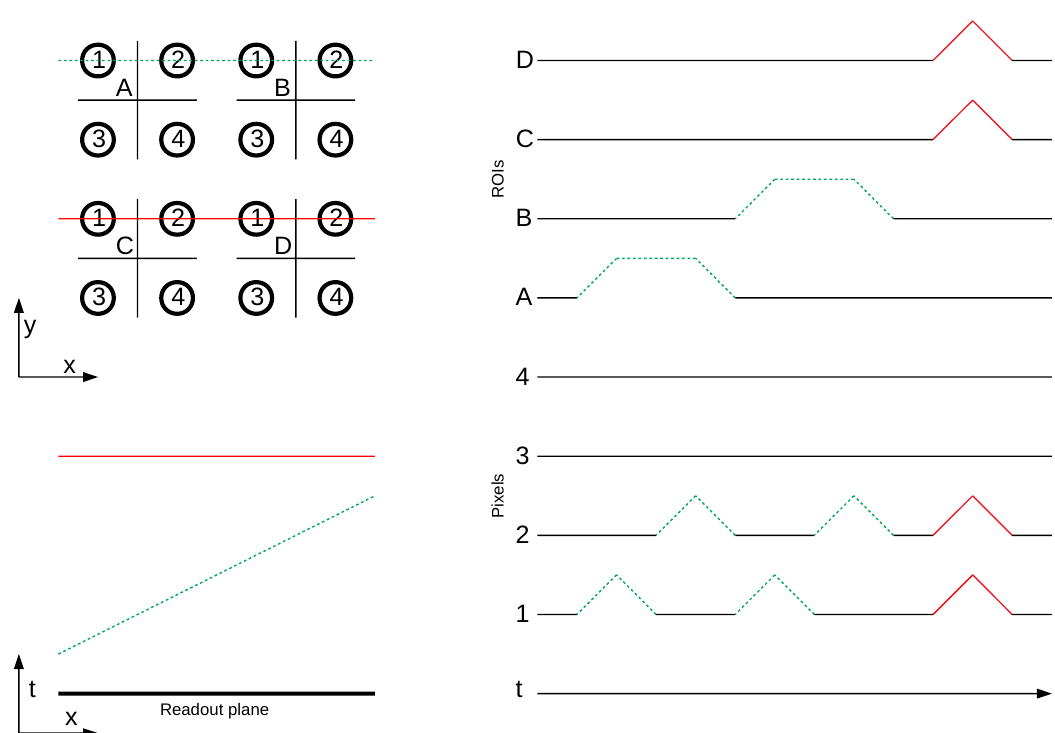
Figure 3. Example of the multiplexing scheme: readout plane with ionization tracks on the left, DAQ waveforms on the right. 16 pixels are read out by 4 DAQ channels (1 to 4) by connecting four pixels to each of the four DAQ channels. In addition, four DAQ channels are required to read out the four inductive grids A to D required to derive the physical position of the collecting pixel, regions of interest (ROIs). Dashed green and solid red lines are two examples of ionization tracks. The green track, inducing a signal in only one grid simultaneously can be reconstructed unambiguously. However, the red track induces signals in grids C and D simultaneously, the physical position of the collecting pixels cannot be unambiguously derived purely from the acquired waveforms. Please note that geometry, timing, and pulse shapes are not to scale. Induction signals are, however, unipolar also in reality because the ionization charge does not drift past the induction grids as in a conventional wire